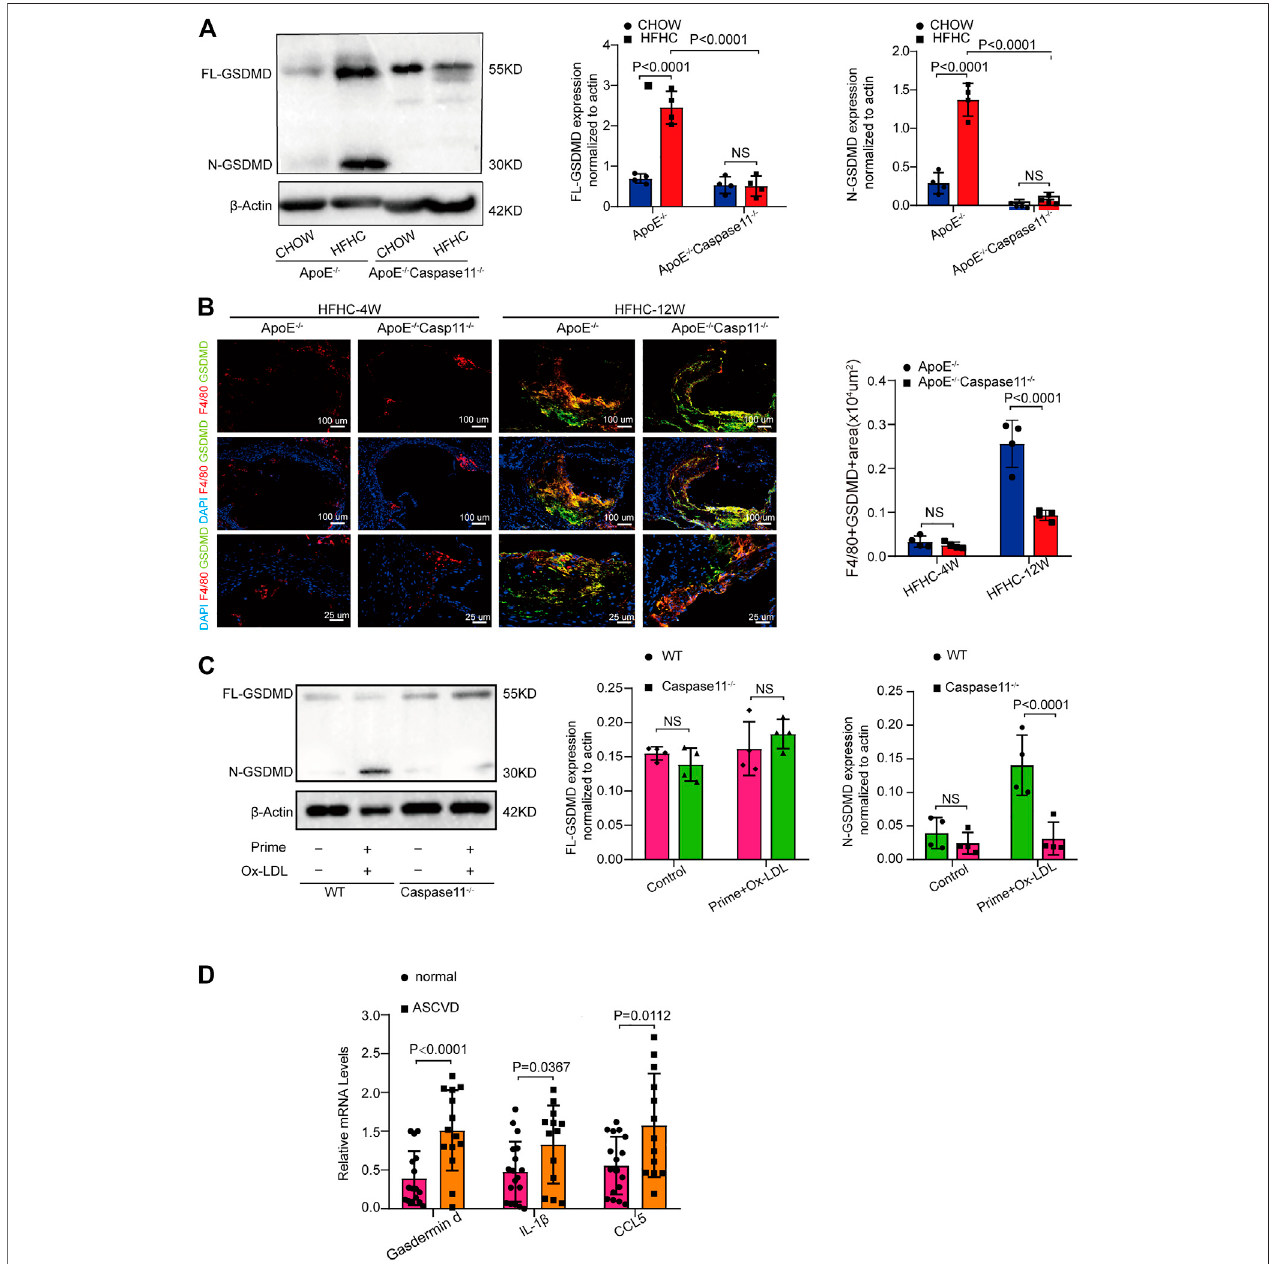
FIGURE 4 | Caspase-11 de fi ciency attenuates atherosclerosis via blocking the activation of gasdermin D in macrophage. (A) Left, representative western blot of the cleaved and total protein levels of gasdermin D in the aortas of WT, ApoE − / − and ApoE − / − Caspase-11 − / − mice after twelve weeks of chow diet or HFHC diet ( n (cid:2) 4 mice per group). Middle, quantitative analysis of the levels of N-GSDMD. Right, quantitative results ofthe protein levels of FL-GSDMD. (B) Left, representative images of gasderminD(green),F4/80(red)andDAPI(blue)oftheF4/80andgasderminDpositiveareaofaorticrootsectionsinApoE − / − andApoE − / − Caspase11 − / − miceafter 4 and 12 weeks of HFHC diet ( n (cid:2) 4 per group). Right, quanti fi cation analysis of the F4/80 and gasdermin D positive area of aortic root sections in the indicated groups ( n ≥ 20 fi elds per group). (C) Left, the protein expression of the cleaved and total protein levels of gasdermin D in peritoneal macrophage from WT and caspase-11 − / − mice primed with LPS for 5 h and then treated with ox-LDL for 16 h after LPS administration was determined by western blotting. Middle, quantitative analysis of the levels of N-GSDMD. Right, quantitative results of the protein levels of FL-GSDMD ( n (cid:2) 4 samples per group). (D) The quanti fi cation of gasdermin D, IL-1 β , CCL5 mRNA levelsinperipheralbloodmonocytesinpatientswithcoronaryheartdiseasesandthecontrolgroup( n (cid:2) 10pergroup).Datashownaremean ± SD (A – D) .Datawere fi rst analyzed and passed normality test (Shapiro-Wilk test). p values were shown and assessed by one-way ANOVA with Tukey ’ s test (A) , by Mann-Whitney test (B, C) and by unpaired two-tailed t test (D). All of the p values were labelled on the pictures and p < 0.05 was considered to indicate statistical signi fi cance. GSDMD, gasdermin D.